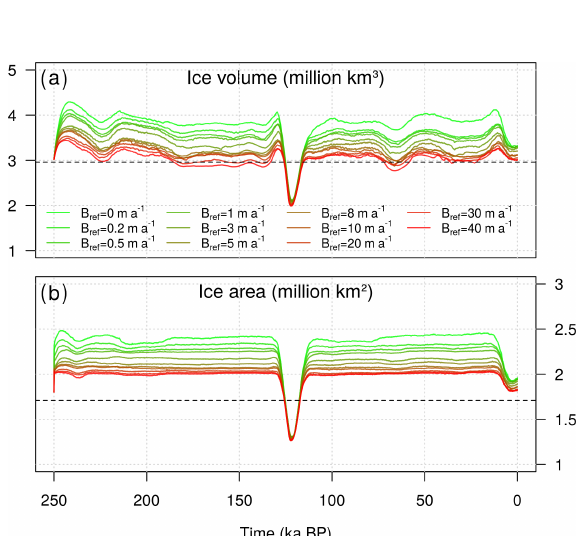
Figure 2. Time evolution of (a) grounded ice volume (millionkm 3 ) and (b) ice-covered area (millionkm 2 ) simulated for different val- ues of B ref (ma − 1 ) having set κ = 0 (see Table 1). Dashed lines show the present-day estimated volume and area of the GrIS (Bam- ber et al.,